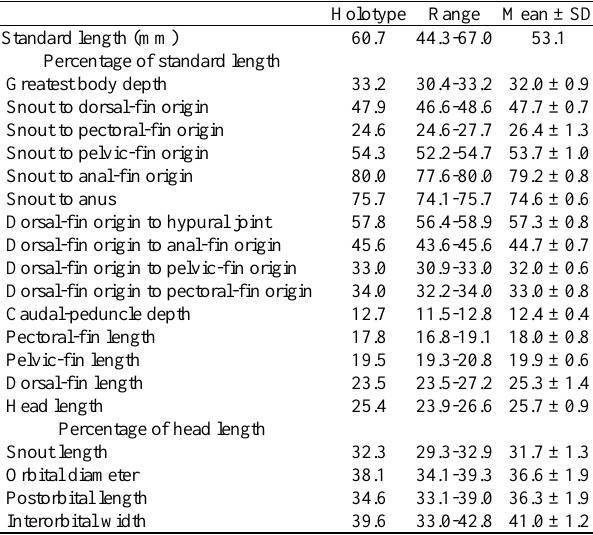
Table 1. Morphometric data for Cyphocharax sanctigabrielis (N = 7) . Range includes holotype and paratypes. SD = standard